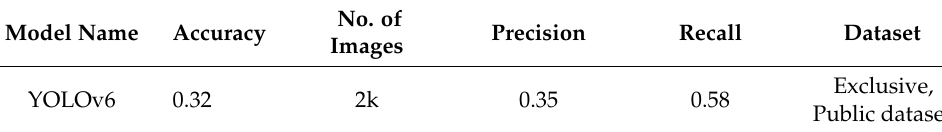
Table 10. YOLOv6